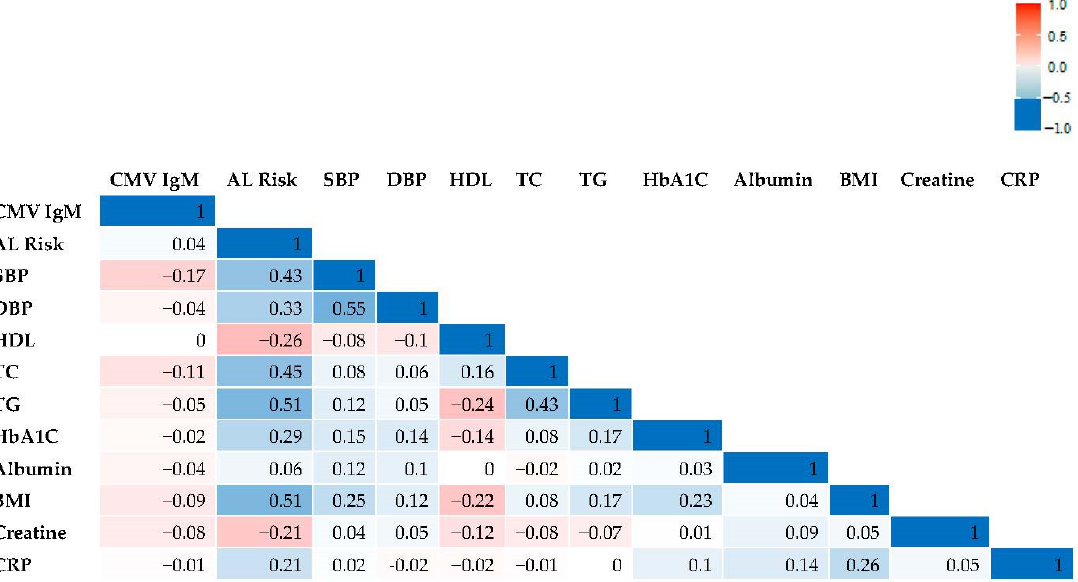
Figure 1. Correlation matrix of AL, CMV, and AL biomarkers (Pearson correlation coefficient). Binary logistic regression models were developed to study the association between